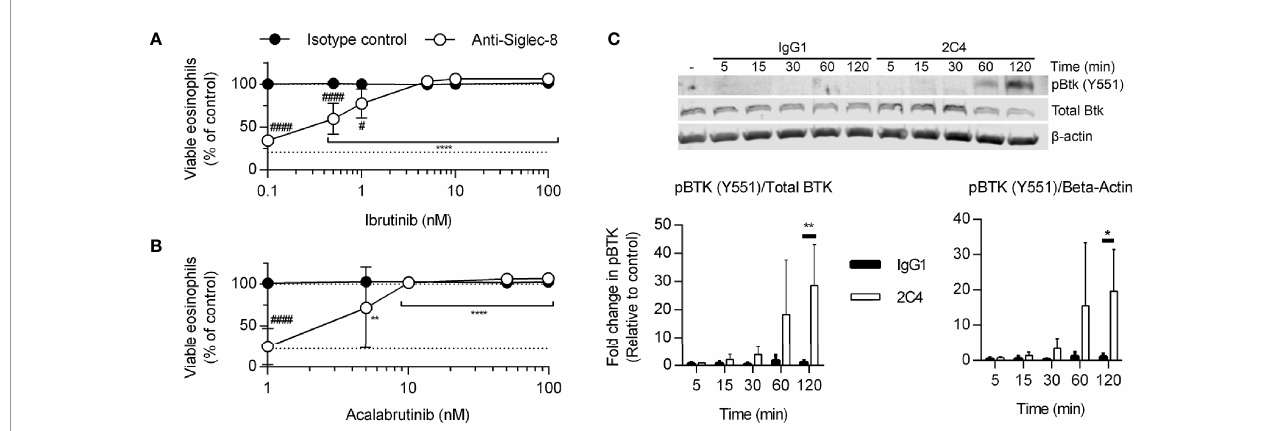
FIGURE 3 | Btk is activated late in the Siglec-8 signaling pathway and is necessary for Siglec-8 – induced eosinophil cell death. Human eosinophils were stimulated with IL-5 and pretreated with the indicated concentrations of the Btk inhibitors ibrutinib (A) or acalabrutinib (B) for 30 min prior to treatment with anti-Siglec-8 (open circles) or isotype control ( fi lled circles) for 18 – 24 h. Eosinophil viability was then assessed by annexin V/DAPI staining as before. Dotted lines indicate viability levels with no pharmacological inhibition. Plots represent mean normalized eosinophil viability ± standard deviations for 3 independent experiments. **p < 0.01, **** p < 0.0001 relative to within – antibody stimulation group vehicle control sample. # p < 0.05, #### p < 0.0001 relative to isotype control sample at the same pharmacological inhibitor concentration. (C) Eosinophils were treated with anti-Siglec-8 mAb (2C4, white columns), isotype control mAb (IgG1, black columns), or left untreated for the indicated durations before lysis and separation of proteins by SDS-PAGE. Immunoblotting for phospho-Btk, total Btk, and b -actin was performed. The blot is representative of 3 independent experiments. Quantitation of phospho-Btk relative to b -actin or total Btk normalized to the untreated eosinophils is shown. The data represent means ± standard deviations for 3 independent experiments. *p < 0.05; **p <